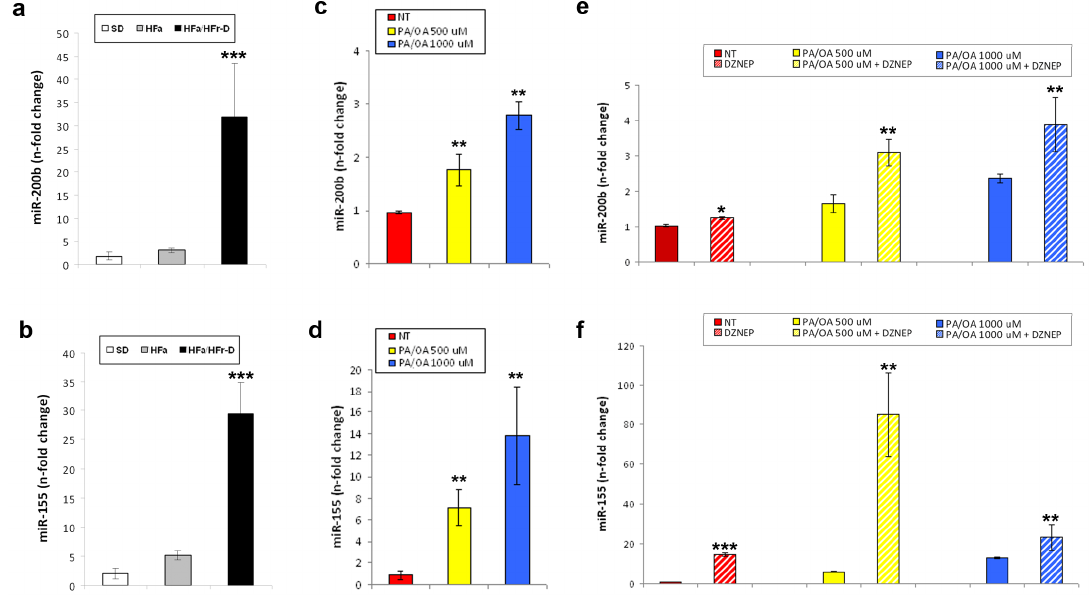
Figure 5. miR-200b ( a ) and miR-155 ( b ) expression levels in SD and HFa/HFr-D rats. Real-Time RT-qPCR results for miR-200b ( c ) and miR-155 ( d ) in HepG2 cells normal or treated with 500 or 1000 µM PA/OA for 24 h; Expression levels of miR-200b ( e ) and miR-155 ( f ) in FFA-treated or untreated HepG2 cells pre-exposed to DZNep. Histograms represent the mean ± SD of at least two independent experiments in triplicate. * p < 0.05, ** p < 0.01 and *** p < 0.001 vs . the respective